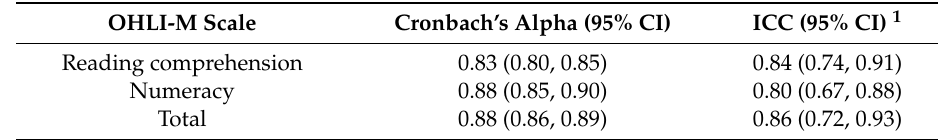
Table 5. Internal consistency (by Cronbach’s alpha, n = 195) and test-retest reliability (by intraclass correlation, n = 50) of